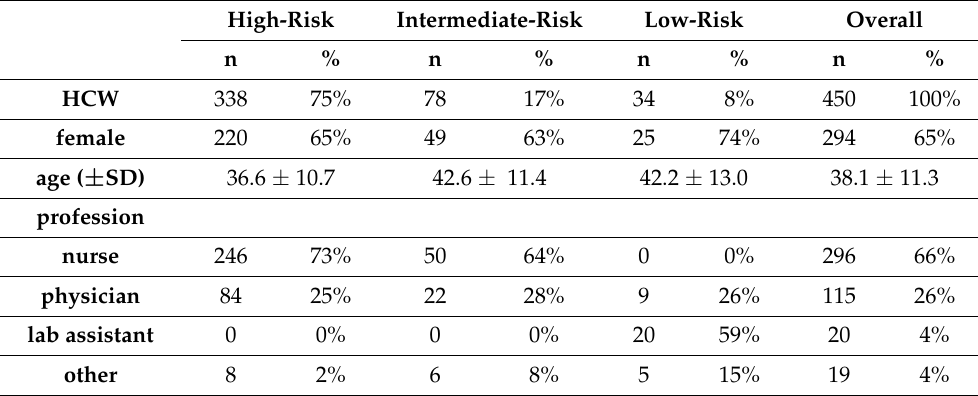
Table 1. Participant’s characteristics, subject characteristics, SD standard deviation, SARS-CoV-2 severe acute respiratory syndrome coronavirus 2, IgG immunoglobulin G, S/co signal-to-cut-off ratio. HCW healthcare workers.